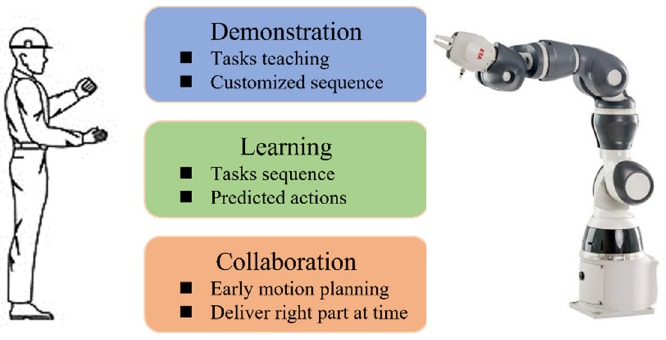
Figure 2. The scheme of the learning from demonstration model.